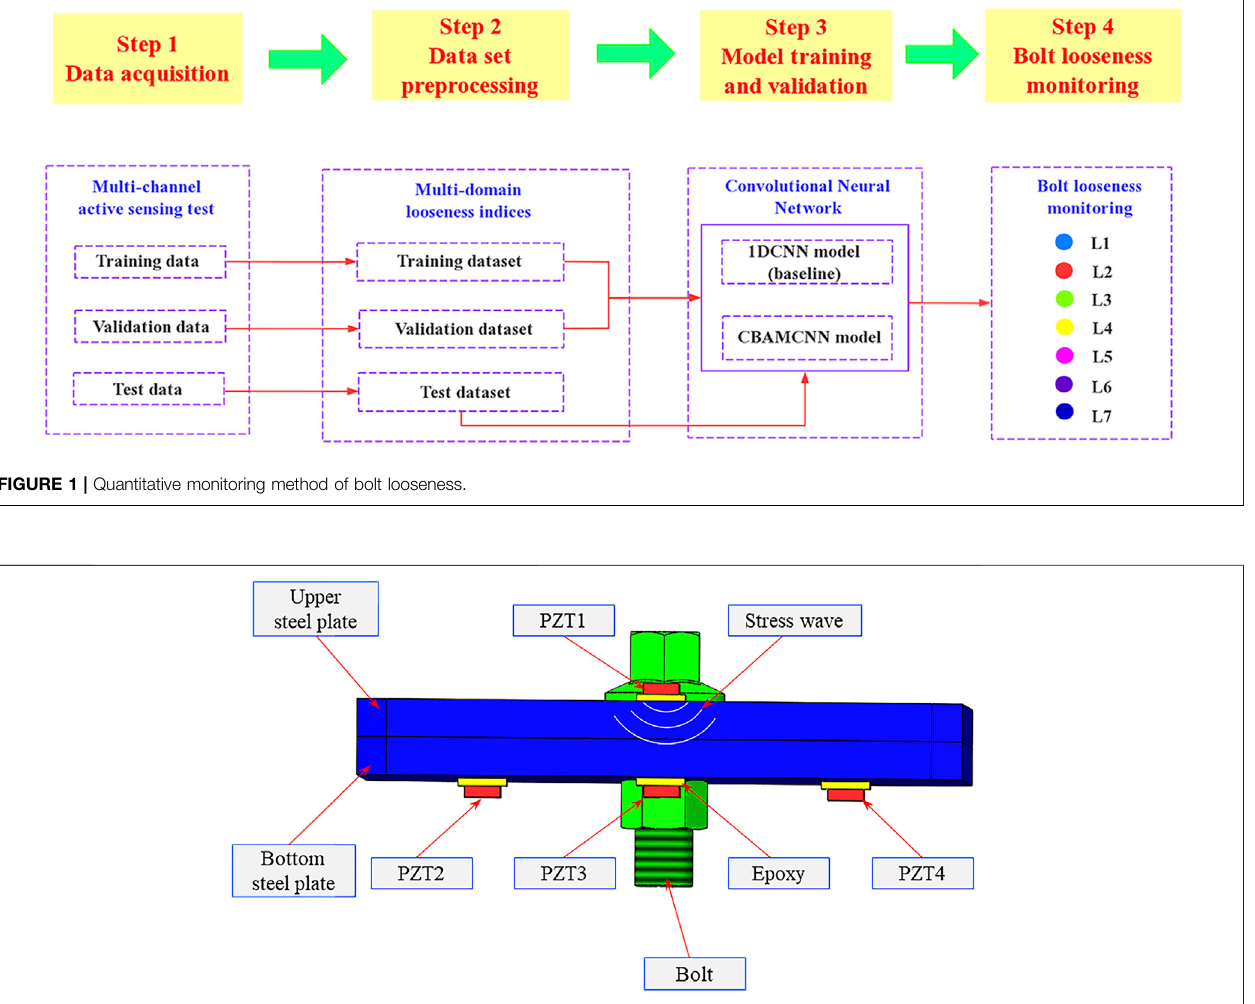
FIGURE 2 | Diagram illustrating the active sensing approach to monitor bolt